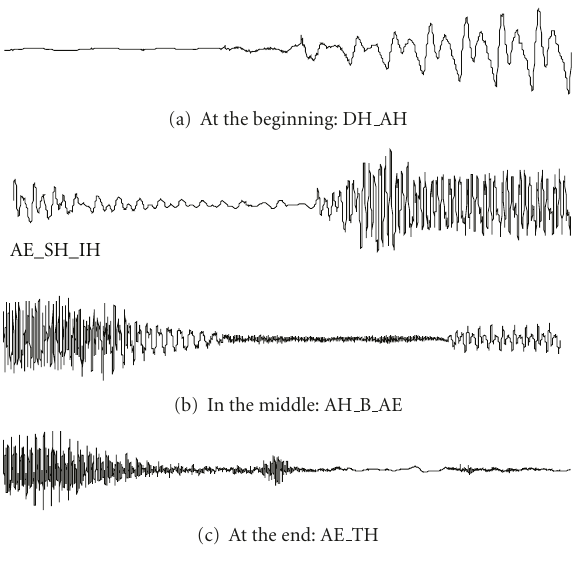
Figure 2: The three di ff erent segmented units of the dysarthric speaker